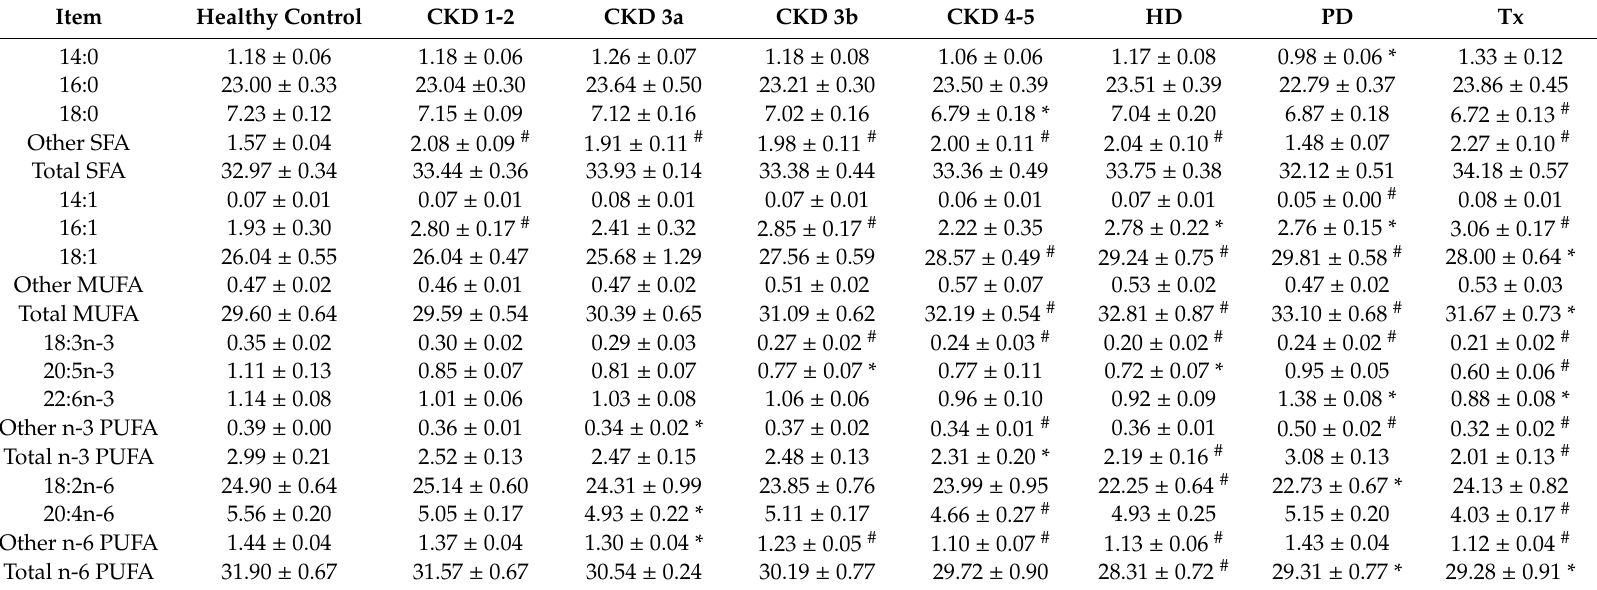
Table 2. The percent content of the main classes of fatty acids in serum of patients at successive stages of chronic kidney disease (CKD). The data are presented as fatty acid proportions (%). * statistically significant comparing to controls at p < 0.05; # p < 0.01. SFA—saturated fatty acids, MUFA—monounsaturated fatty acids, PUFA—polyunsaturated fatty